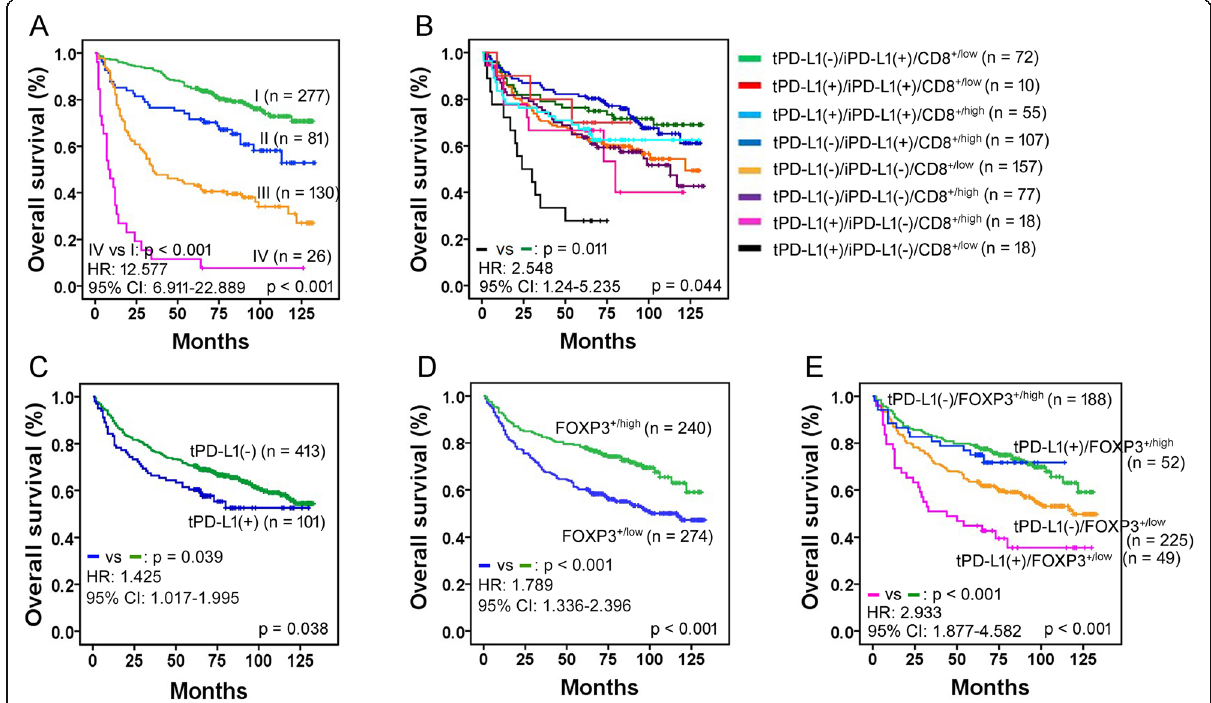
Fig. 2 Kaplan-Meier survival plots of overall survival. In the entire cohort ( N = 514), the subgroups with more advanced-stage tumors ( a ), the combined subset of tumoral PD-L1(+)/immune cell PD-L1( − )/CD8 +low tumors ( b ) exhibit the lowest rates of patient survival within each corresponding analysis based on the Cox proportional hazards model. I, II, III and IV in (A) indicate TNM tumor stage. Tumoral PD-L1(+) ( c ), FOXP3 +/low ( d ), and the combined subset of tumoral PD-L1(+)/FOXP3 +/low tumors ( e ) reveal the lowest rates of patient survival through each corresponding univariate analysis. Corresponding P value, hazard ratio (HR) and 95% confidence interval (CI) in the worst prognostic subset are shown in the bottom left corner of each plot, and P values throughout all subsets, in the bottom right corner of each